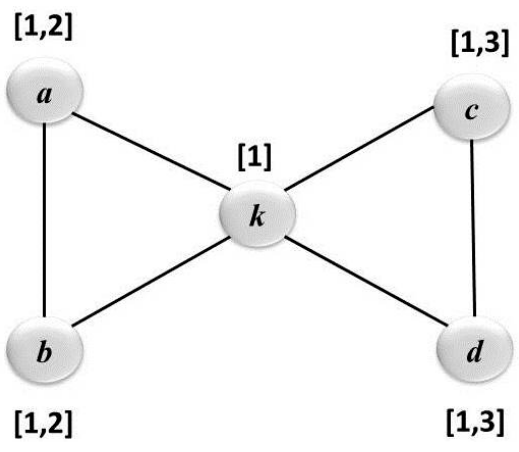
Figure 4. An example of irrational involvement of licensed channels.